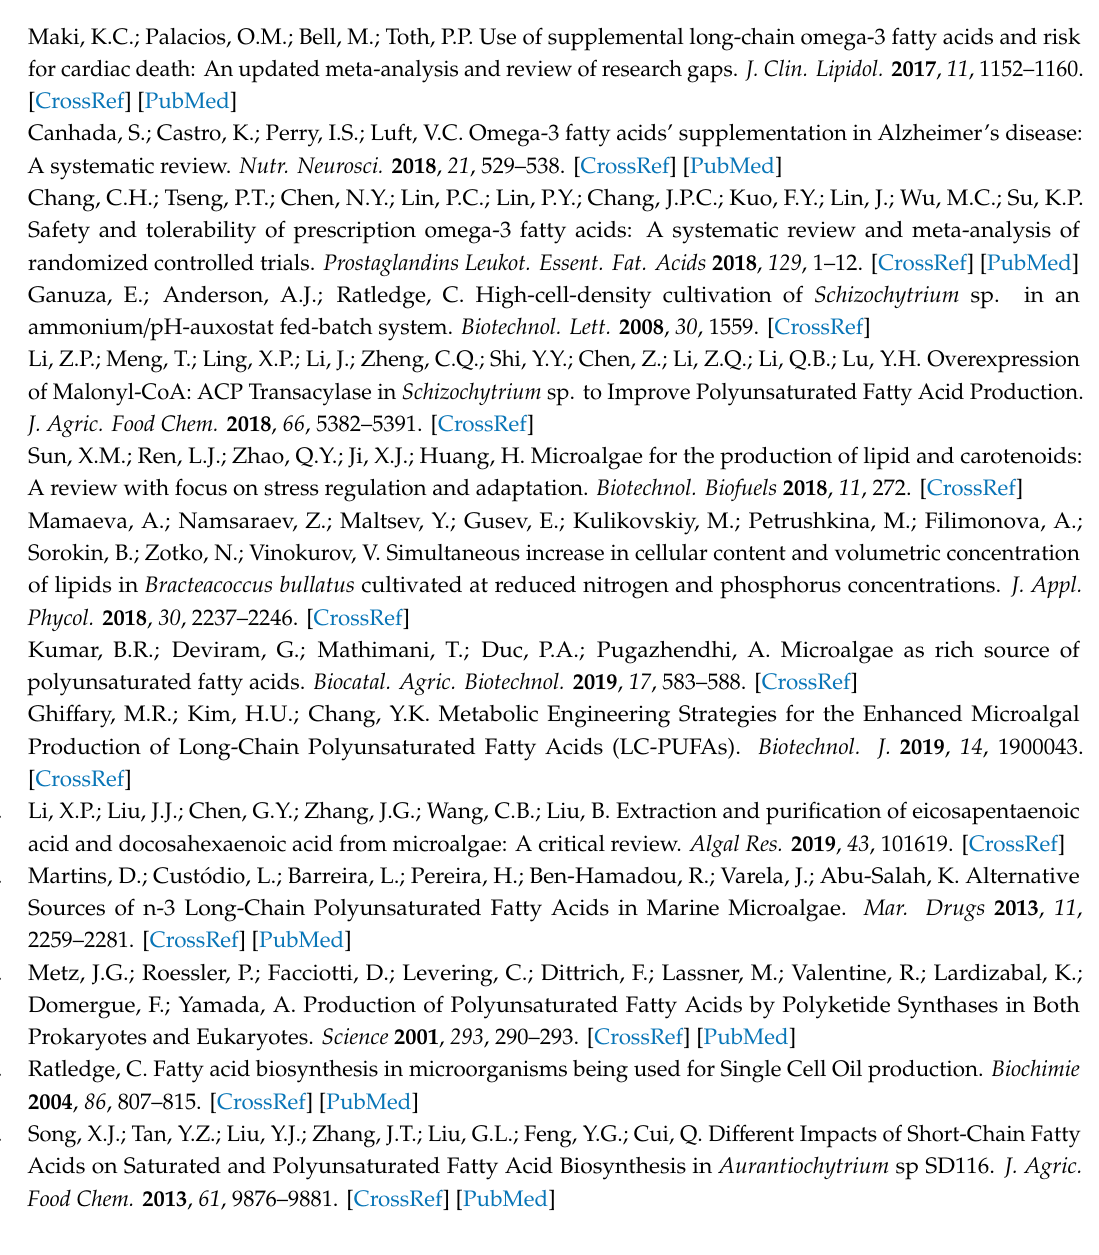
Figure S1: The gene expression profile of the OrfB-ER , OrfC-ER and DH at maximum lipid content period by RT-qPCR from wild type strain. Figure S2: E ff ect of di ff erent concentration of triclosan added at 0 h on (a) Biomass, (b) Total lipid yield at 120 h, and (c) Fatty acid content in total lipid at 72 h. Table S1: Primers used in vector construction and PCR verification of mutants. Table S2: OrfB sequence in Schizochytrium limacinum SR21. Table S3: OrfC sequence in Schizochytrium limacinum SR21. Table S4: Primers used in RT-qPCR for detect expression of the